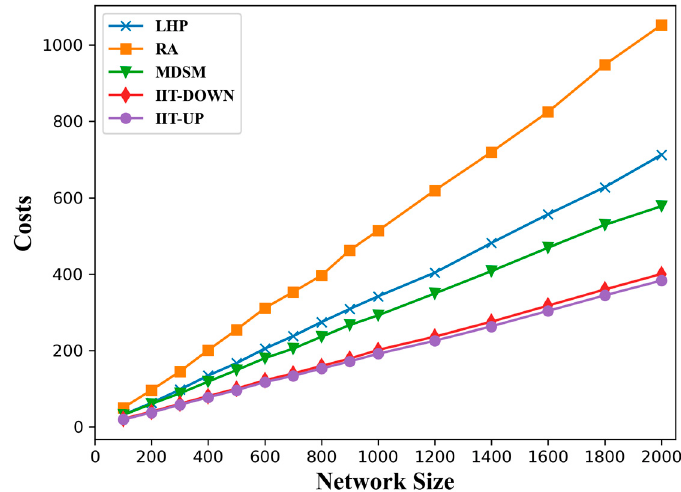
Figure 5. Deployment cost comparison for each algorithm with different network sizes.